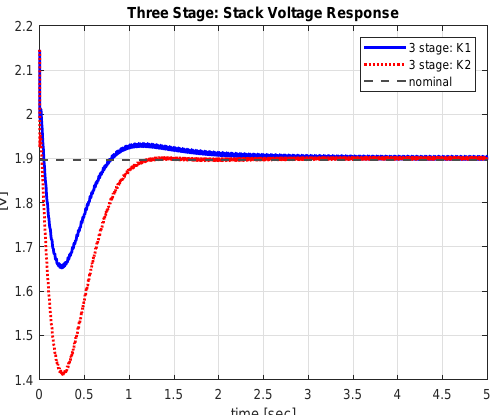
Figure 11. System response (voltage). Simulation results illustrate different responses when K 1 and K 2 controller are used. Depending on the engineering specification further analysis and fine tuning should be conducted to fully use the power of the multistage design technique.